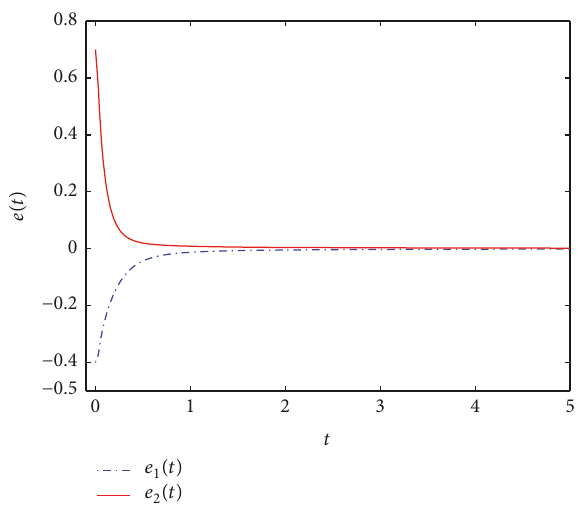
Figure 4: Phase portrait of the drive and response systems in 𝑥 1 − 𝑥 (𝑥 − 𝑥 ) plane with ℎ 3 4 5